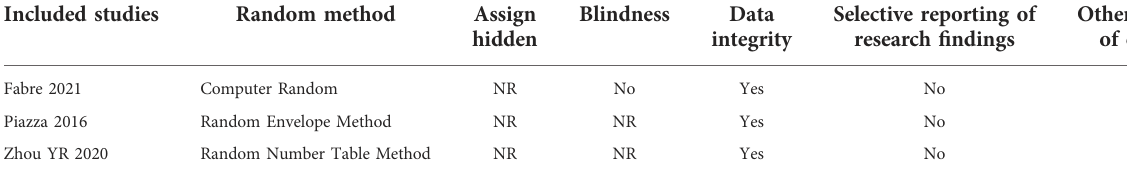
TABLE 3 Inclusion of RCT study bias risk